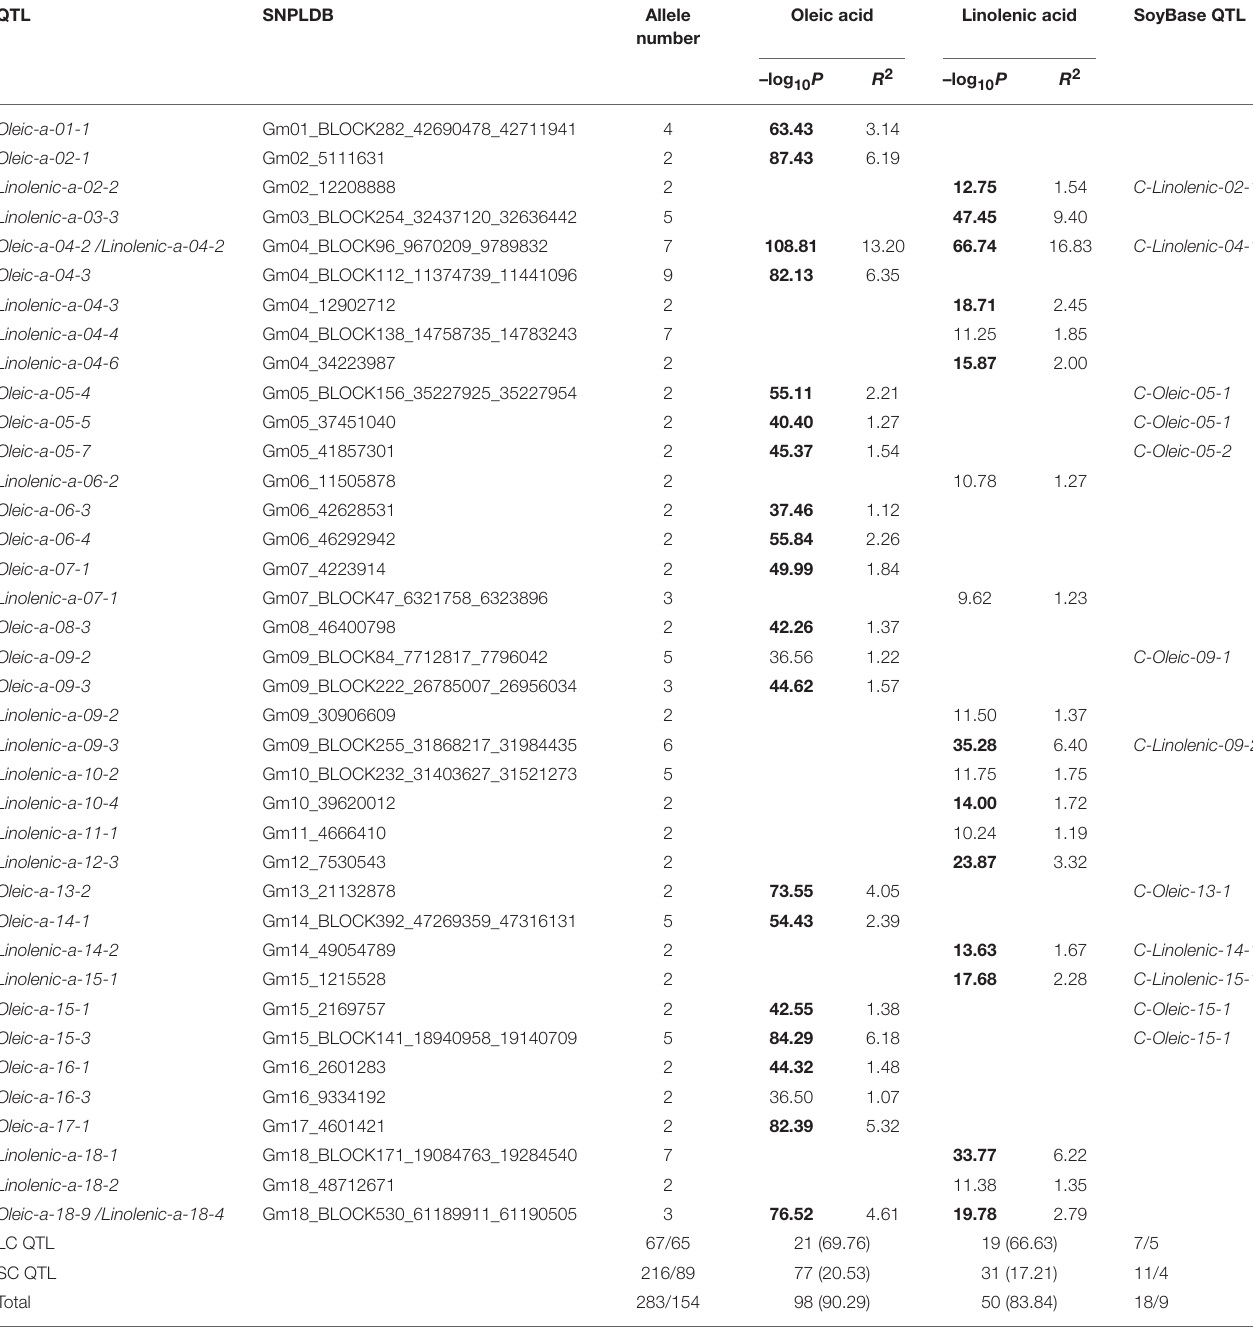
TABLE 4 | The detected SNPLDBs associated with oleic acid and linolenic acid content in CSLRP. QTL SNPLDB Allele